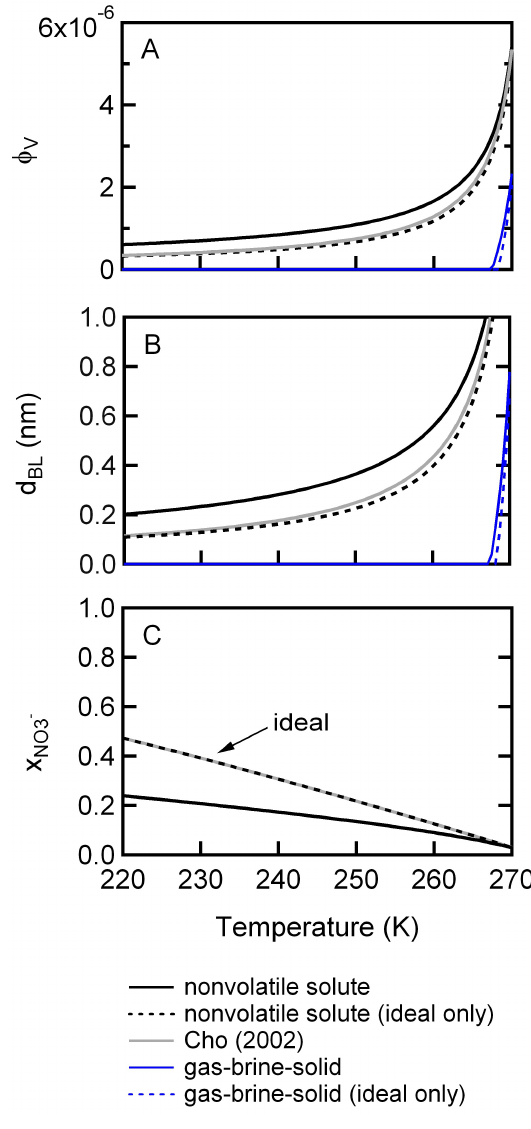
Fig. 4. Model comparison for a melt concentration of 10µM HNO 3 . (A) Brine volume fraction, (B) brine thickness calculated assuming spherical ice crystals, 1mm in radius and (C) nitrate mole fraction in the brine are shown using our models assuming nonvolatile solute (black) or enforcing solute partitioning among the gas, brine, and ice matrix (blue). Results from the full models which account for non-ideal behavior (solid lines) or assuming ideal behavior (dashed lines) are shown. Predictions from the model of Cho et al. (2002) are shown for comparison (grey